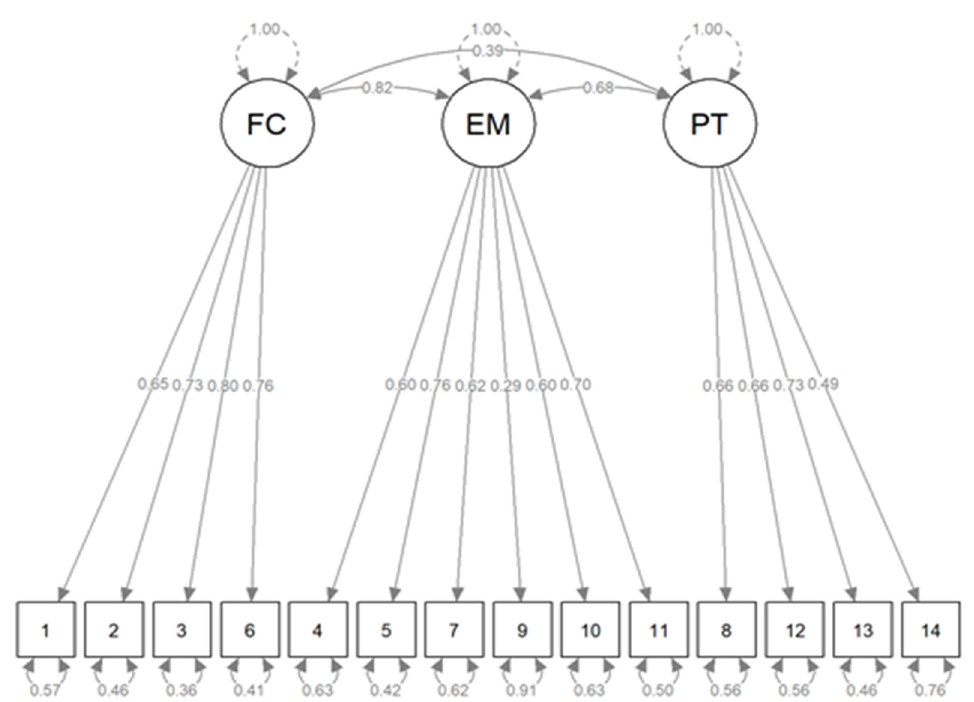
Figure 4. Path diagram of the Three-factor model (standardized solution). Identity numbers identify items. Factors: FC—Futile Care, EM—Ethical Misconduct, PT—Poor Teamwork.